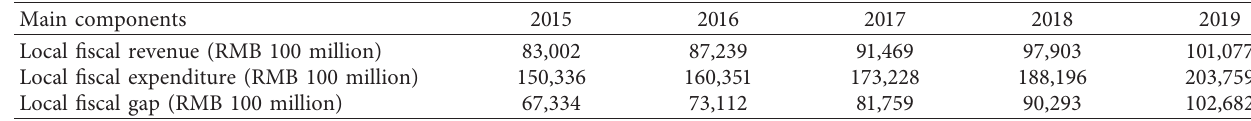
Table 3: Local fiscal revenue and expenditure